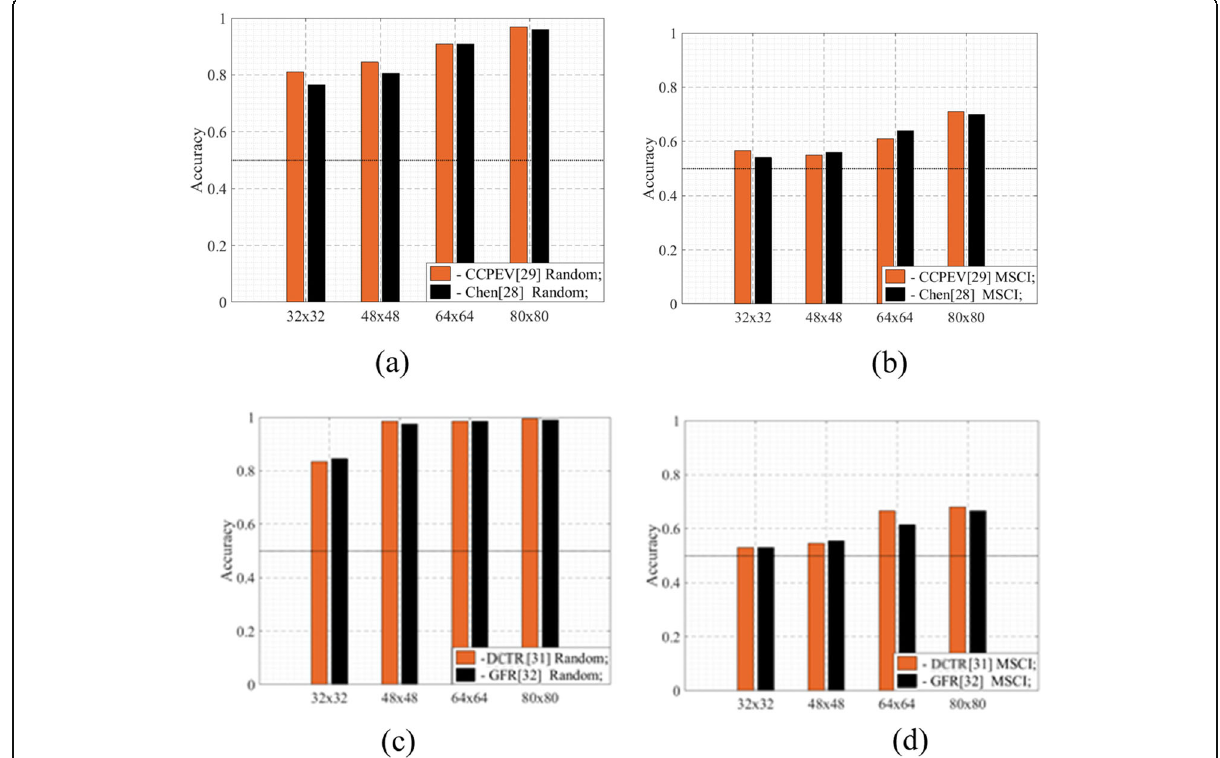
Fig. 10 a , c Detection accuracy for random cover selection and b , d MSCI choice; different steganalysis techniques were used: a , b CCPEV and Chen c , d GFR and